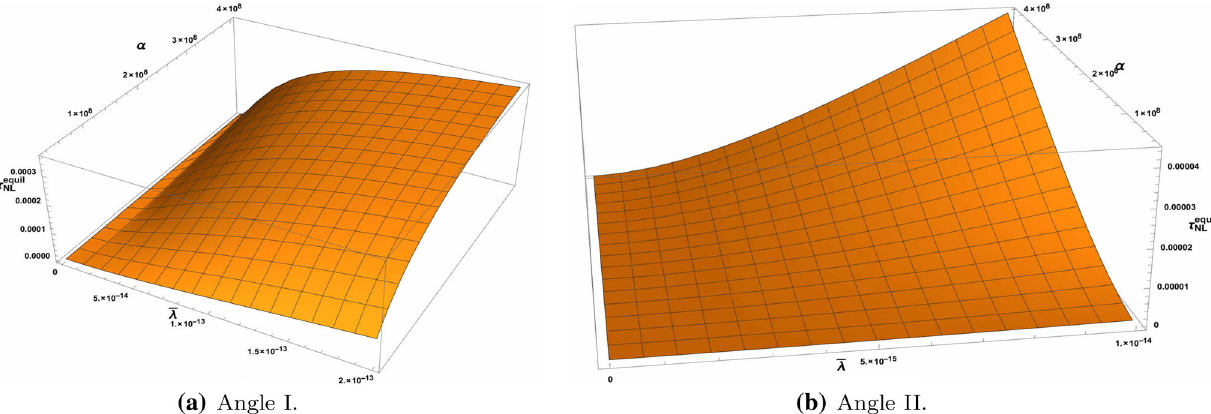
Fig. 21 Representative 3D diagram for equilateral non-Gaussian three point amplitude vs. the model parameters α and ¯ λ for N cmb = 60 in two different angular views